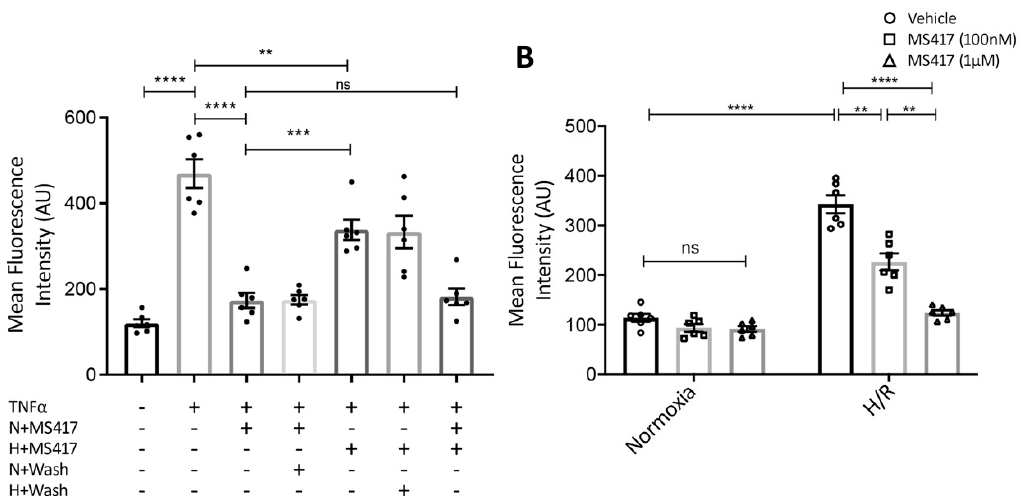
Figure 4. BRD4 inhibition attenuated neutrophil adhesion to the endothelium ( A ) BRD4 inhibition attenuated neutrophil adhesion to the endothelium with treatment to the neutrophils, endothelial cells, or combined. Isolated human neutrophils (10 5 cells / well) or TNF α -stimulated HUVEC monolayers were treated with 1 µ M MS417 for 1 h or left untreated and then co-incubated in various combinations as indicated. In some cases, MS417 was washed out as indicated. Cells were allowed to adhere for 30 min and any non-adherent cells were removed. Adhesion was measured using a fluorescent plate reader at excitation and emission wavelengths of 494 and 517 m, respectively. (N = neutrophils, H = HUVEC). ( B ) To better represent IRI, HUVEC were exposed to 1% O 2 for 2 h followed by 3 h of re-oxygenation. Neutrophil were treated with either 100 nm or 1 µ M of MS417 and adhesion was measured as previously described. Two-way ANOVA with Tukey was performed. n = 6, ** p < 0.01, *** p < 0.001, **** p <